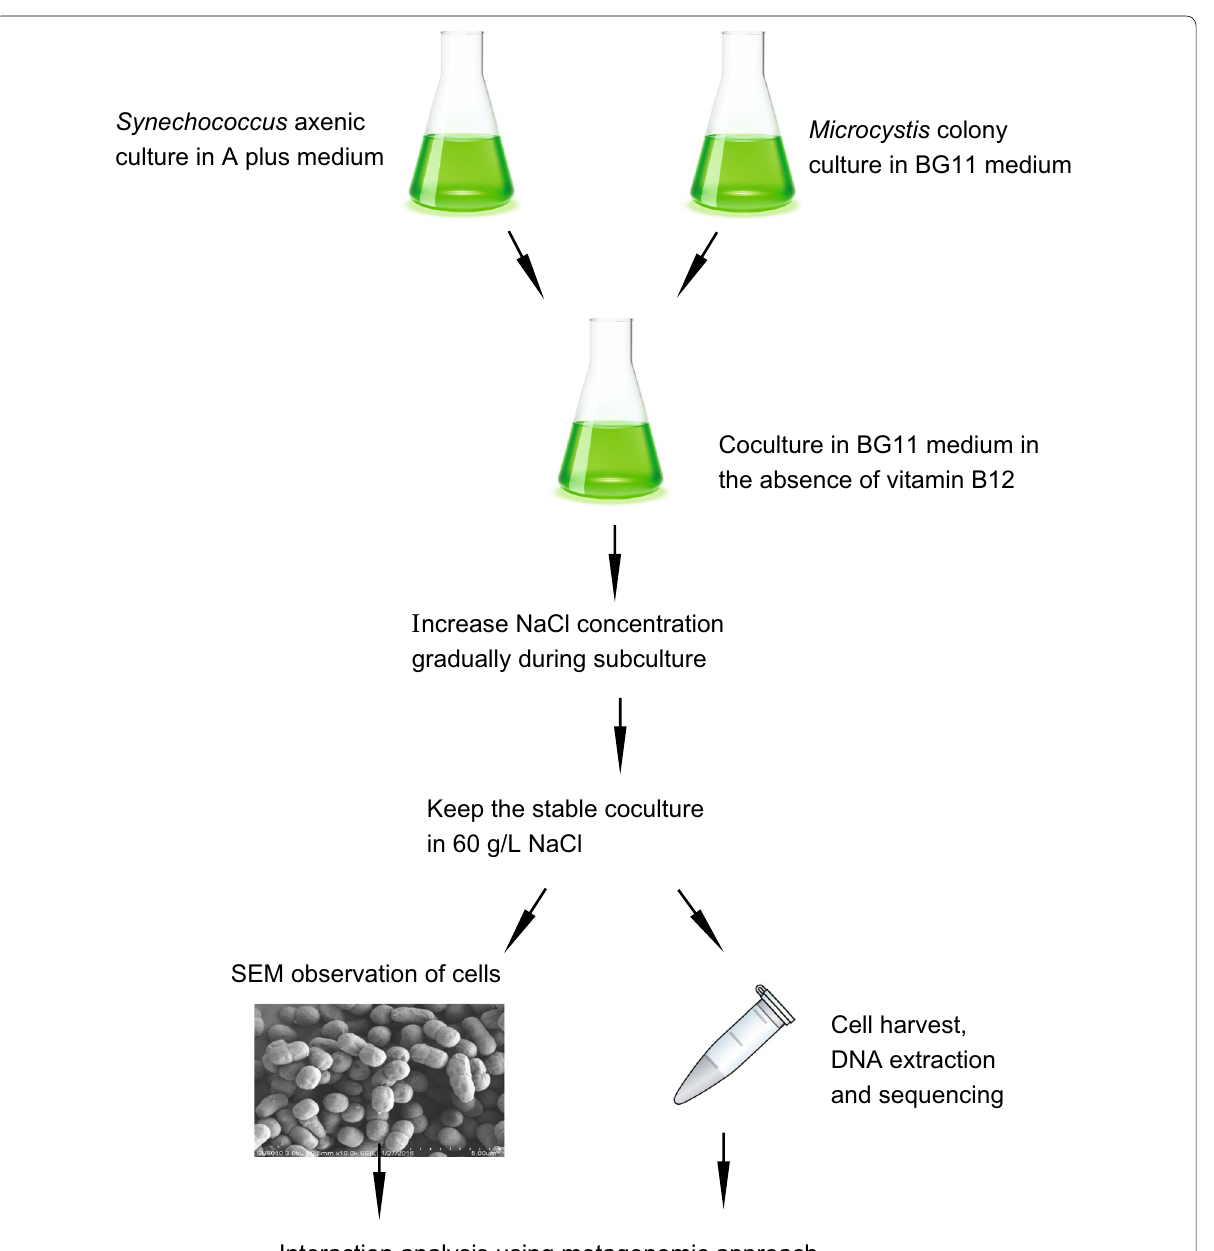
file 1: Figure S1, Table S1). Our observation is consistent